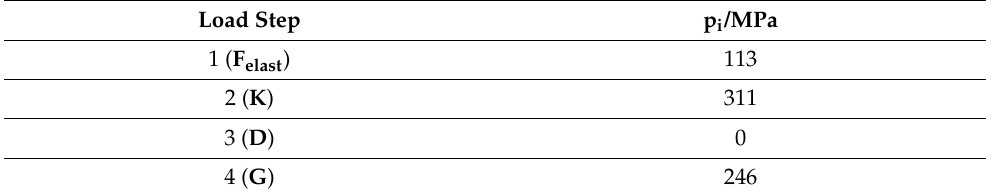
Table 2. Load steps of the load history of the ideal plastic behavior of a material, according to Figure 3.